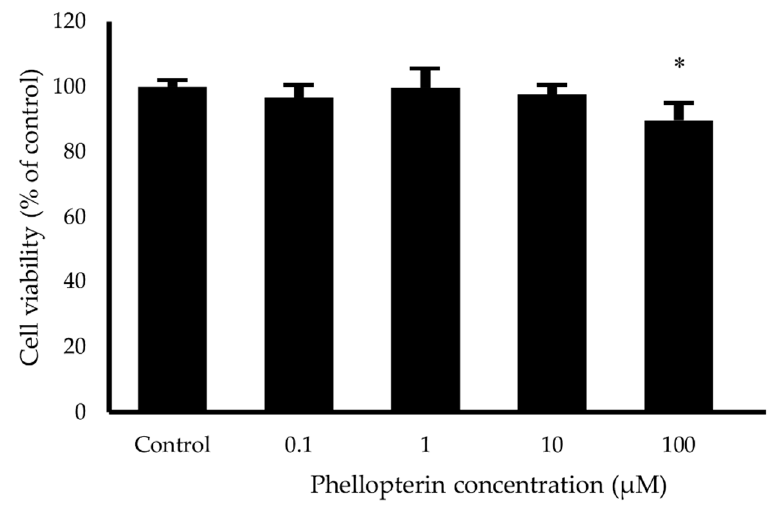
Figure 4. Effects of phellopterin on cell viability of SH-SY5Y cells. The values are reported as mean ± SD ( n = 4), Paired t-test was used to compare between control and test inhibitors.